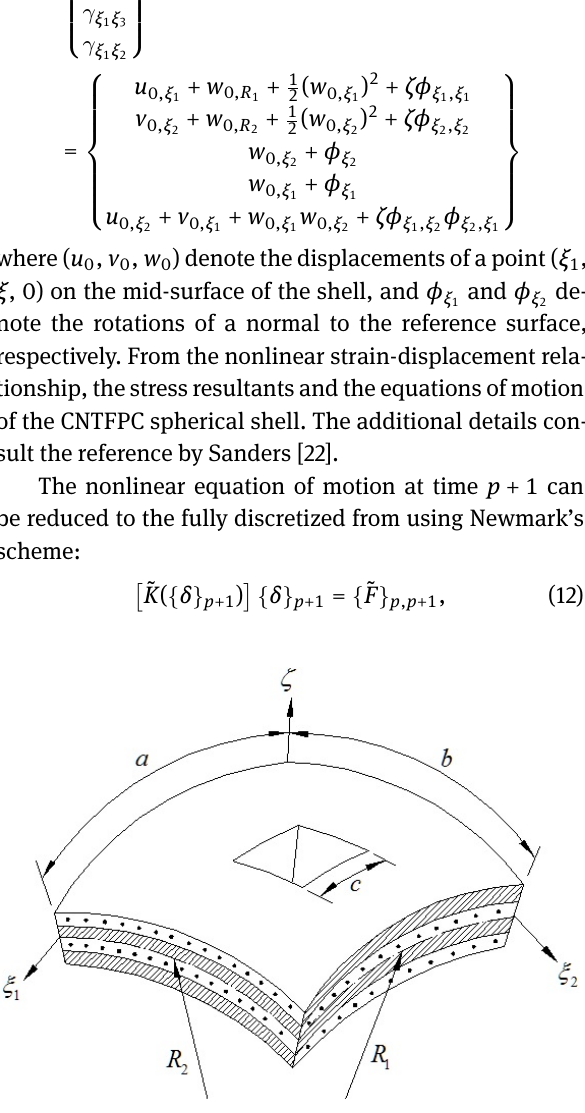
Figure 1: A laminated CNTFPC spherical shell with a central